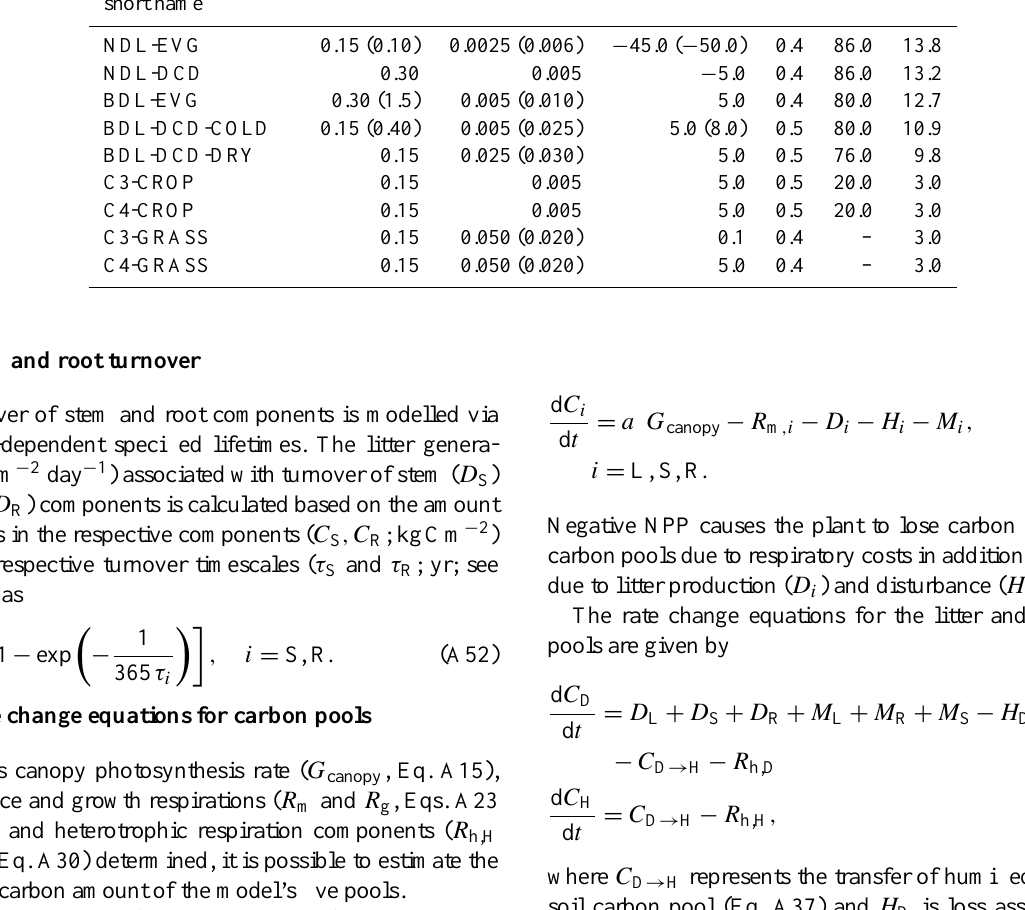
Table A5. PFT-specific parameters used in the phenology module of CTEM v. 2.0: maximum cold ( (cid:127) C,max , day − 1 , Eq. A49) and drought ( (cid:127) D , max , day − 1 , Eq. A51) stress loss rates, T leaf ( ◦ C) temperature threshold for determining cold stress scalar L cold (Eq. A50) and the cold fraction L f (Eq. A47) used to determine threshold LAI for switching from maximum growth to normal growth leaf phenology mode. Also shown in the table are the turnover timescales for the stem ( τ S , yr, Eq. A52) and root ( τ R , yr, Eq. A52) components. Some parameter values differ between the model versions when PFTs’ fractional coverage is specified and when they are dynamically modelled using competition between PFTs. If modified, the parameter values for the dynamically modelled version are shown in parentheses. Plant functional type (cid:127) C ,